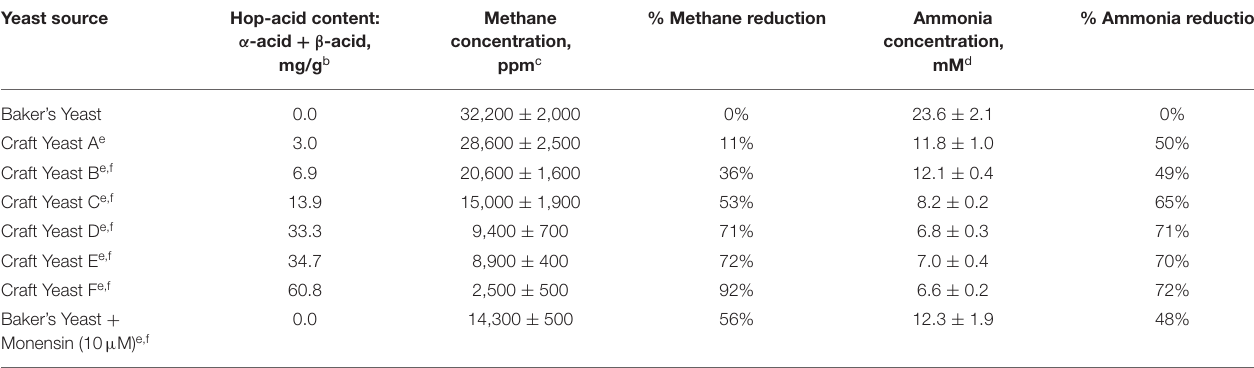
TABLE 2 | Hop acid content in spent craft yeast correlates with inhibition of methane and ammonia by in vitro rumen fluid fermentations a . Yeast source Hop-acid content: